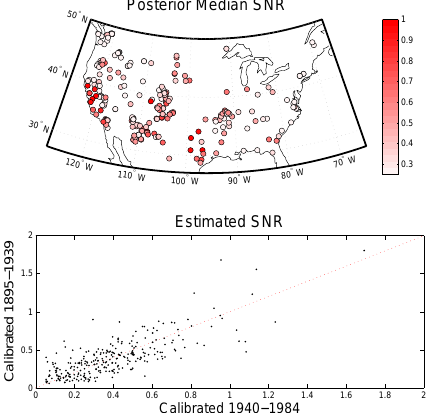
Fig. 6. Top: map of posterior median signal-to-noise ratio (SNR) across sites in network, estimated by comparing simulated and ob- served data during 1895–1939. Bottom: comparison of posterior median SNR estimated during 1895–1939 and 1940–1984 for val- ues of growth response parameters estimated using data in the com- plementary intervals.